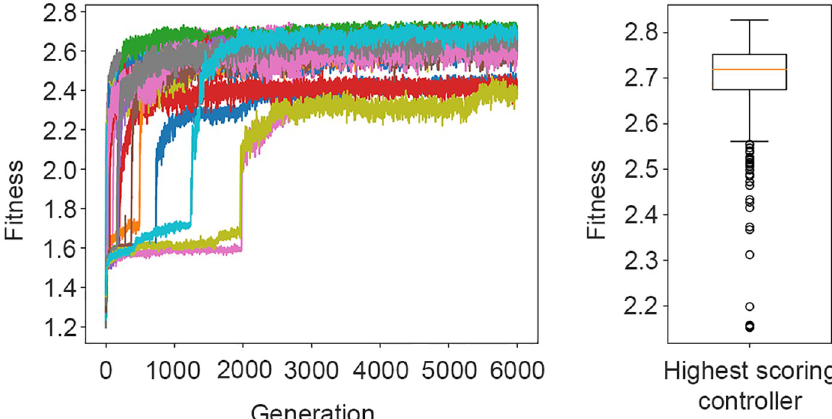
Fig 1. Left: Fitness trajectories of the highest-scoring controllers evolved in each evolutionary run. Right: Distribution of the post-evaluation fitness scores achieved by the highest-scoring controller of the 30 evolutionary runs conducted. The box-plot summarises results from 400 post-evaluation